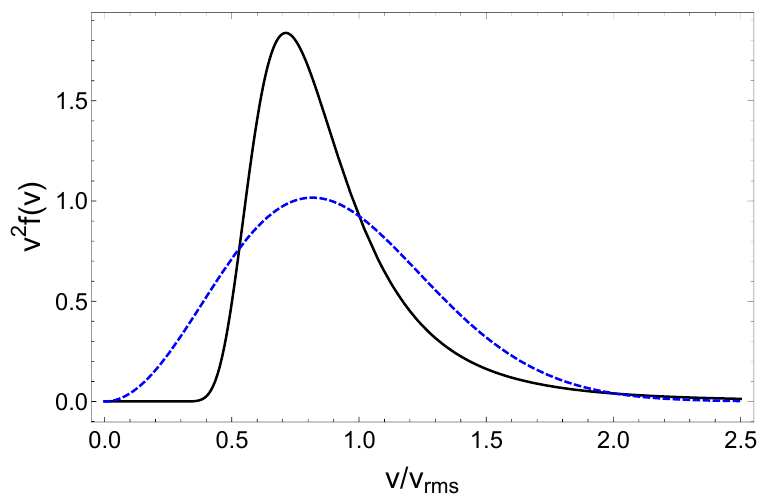
Figure 2. Velocity distribution predicted from extra-dimensional freeze-in (black, solid) as a function of velocity normalized to v rms . For comparison, a thermal Maxwell-Boltzmann distribution with the same v rms is shown (blue,